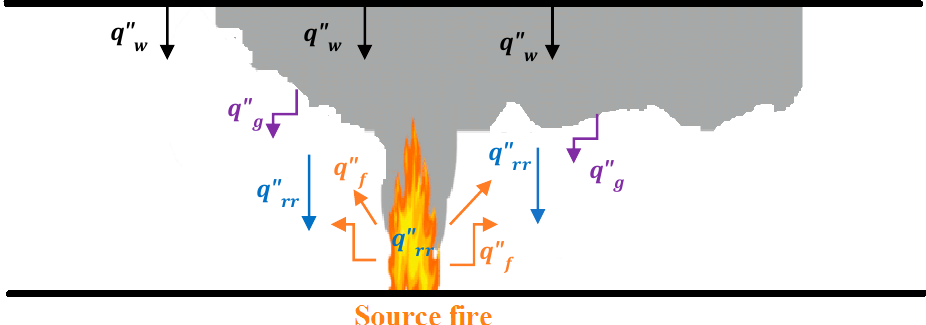
Figure 1. Balance of radiation heat transfer. 143